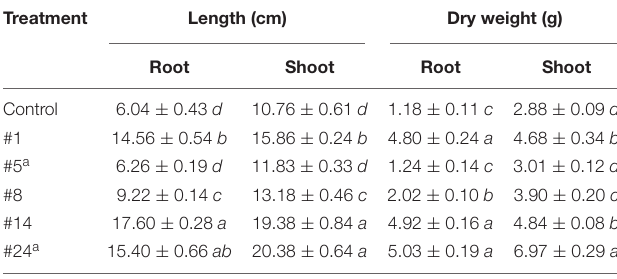
a Isolate #5 represents the endophytic PA-non-producing Streptomyces sp. 19-388, while #24 represents the endophytic PA-producing Streptomyces mutabilis UAE1. Values are means ± SE of eight replicates for each treatment. Values with the same letter for each growth measurement within a column are not significantly (P > 0.05) different according to Fisher’s protected LSD test. Plants were harvested after 6 weeks. PA,